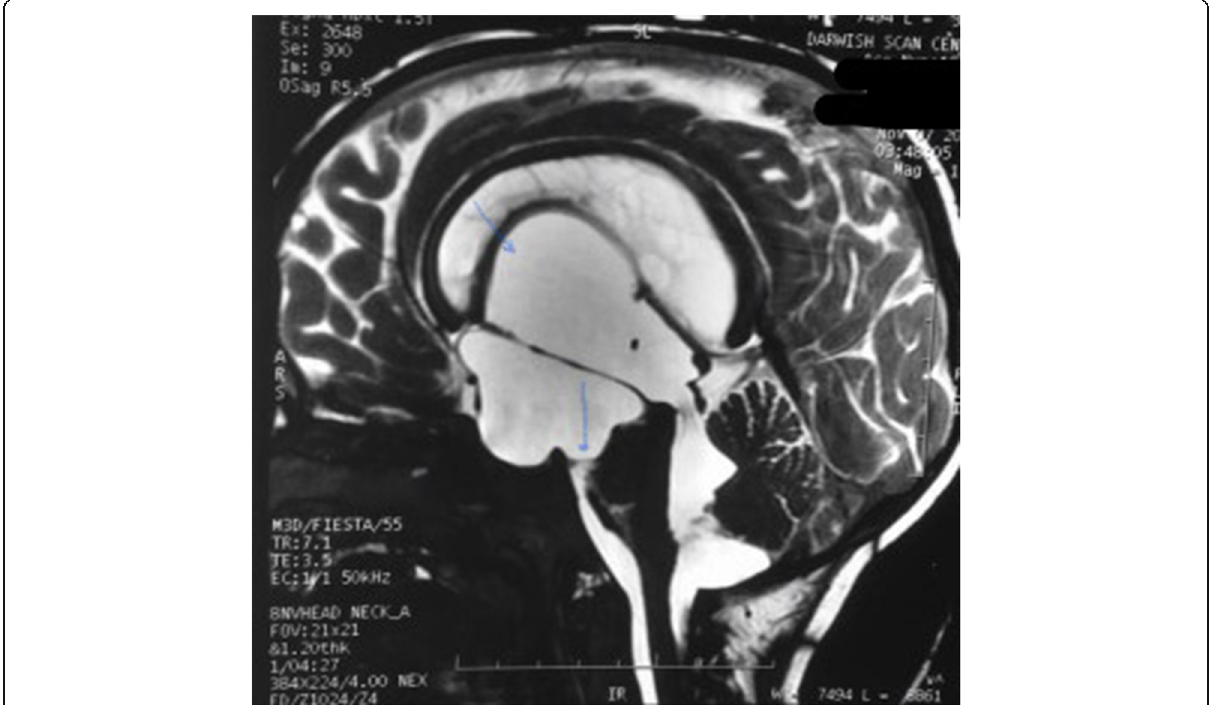
Fig. 3 MRI T2 sagittal sequence with an arrow identifying the site of ventriculocystostomy and cystocisternostomy